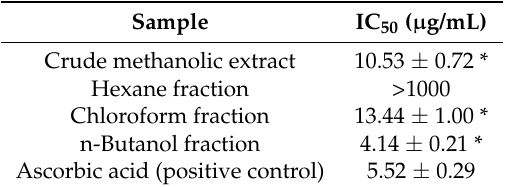
Table 2. Free radical scavenging (DPPH) activity of Averrhoa bilimbi crude methanolic leaves extract and its